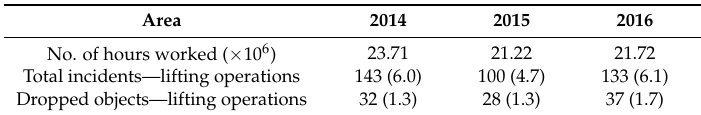
Table 1. Total incidents and dropped objects from 2014 to 2016. [6–8] (Normalized by the number of hours worked and scaled by